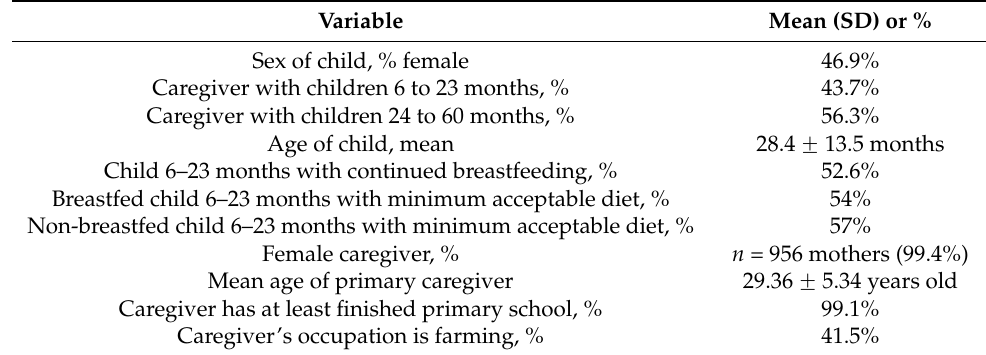
Table 3. Characteristics of the 962 surveyed